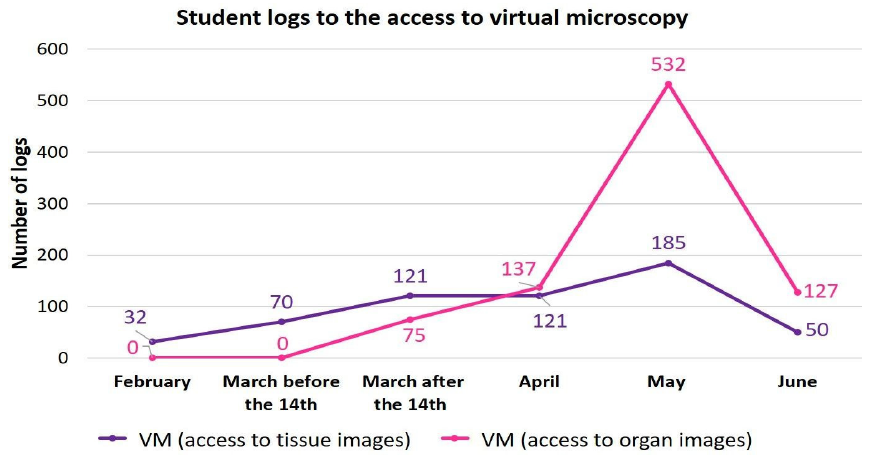
Figure 2. Data collected from Moodle for the cytology and histology elements of the lock- down-adapted course (2019–2020). Logs of views and messages by ( a ) students, and ( b ) lecturers. Referring to Figure 3, the start of microscopic anatomy teaching and lockdown oc- curred within days of each other and, as might be expected, records show increased lev- els of access by students to digital images of organs. A further increase in the use of these images occurred in May, during the exam period (Figure 3).